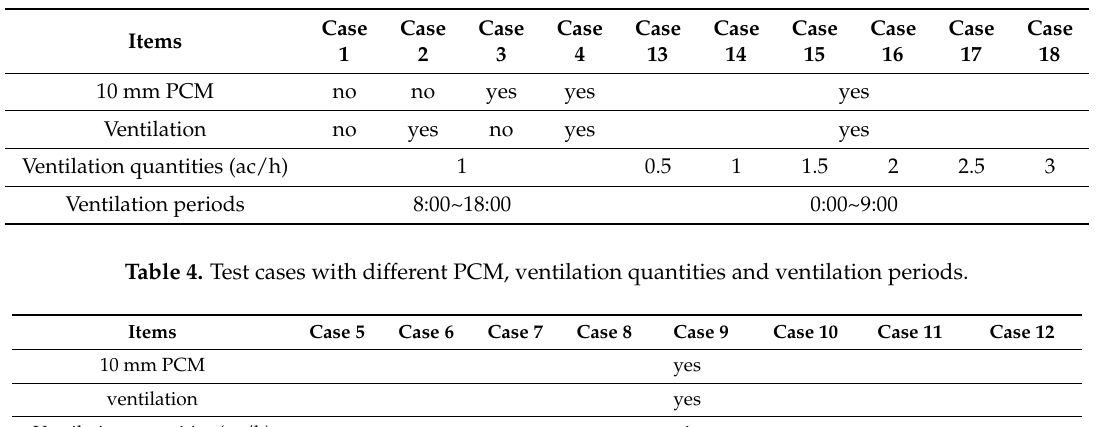
Table 3. Test cases along with different PCM, ventilation quantities and ventilation periods.